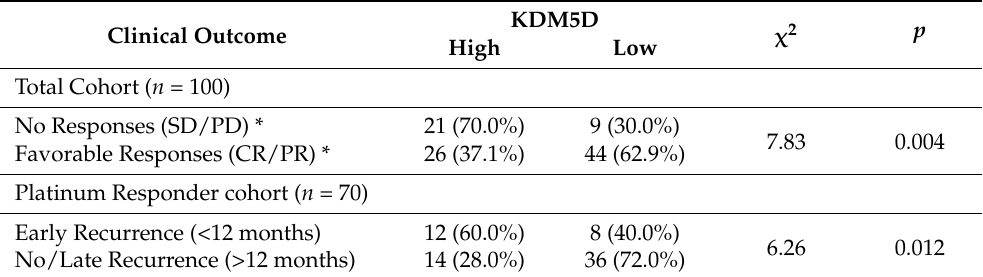
Figure 2. Overexpression of KDM5D was associated with poor platinum responses in HNSCC patients. ( A ) Representative images of KDM5D staining in tissue specimens of TMU-SHH HNSCC cohort in respective order: normal adjacent epithelium, well-differentiated tumor, and poorly differentiated tumors. Higher KDM5D expression was noted in HNSCC tissues than in adjacent normal epithelial tissues. ( B ) The highest KDM5D expression was observed in poorly differentiated squamous cell carcinoma tissues. ( C ) Representative images of KDM5D staining in tissue specimens of TMU-SHH HNSCC cohort according to cisplatin response and recurrence disease. ( D ) Among the patients with HNSCC, KDM5D expression was higher in the platinum non-responders than in the responders. ( E ) Among HNSCC patients who responded to platinum-based chemotherapy, higher KDM5D expression was observed in those with early disease recurrence than those with no/late-recurrence. Significance level: * p < 0.05; *** p < 0.001; **** p < 0.0001. Scale bar: 200 μm . Table 1. Clinicopathological Association between KDM5D Expression and Treatment Outcome of TMU-SHH HNSCC Patients